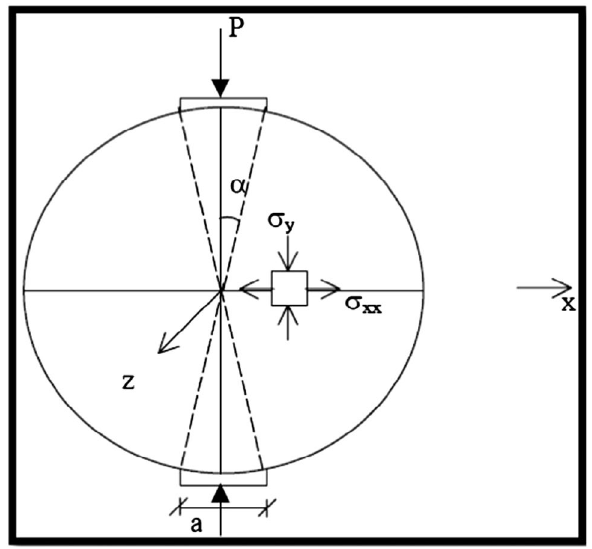
Fig. 4 Schematic of indirect tensile strength (ITS)